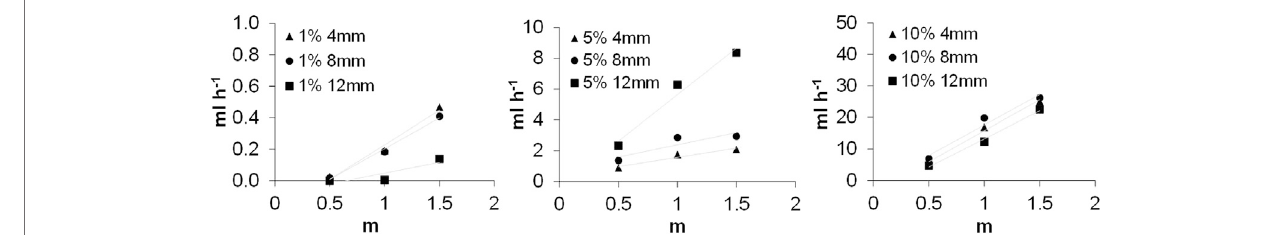
FIGURE 7 | Leaching kinetics for different water head in composite A.